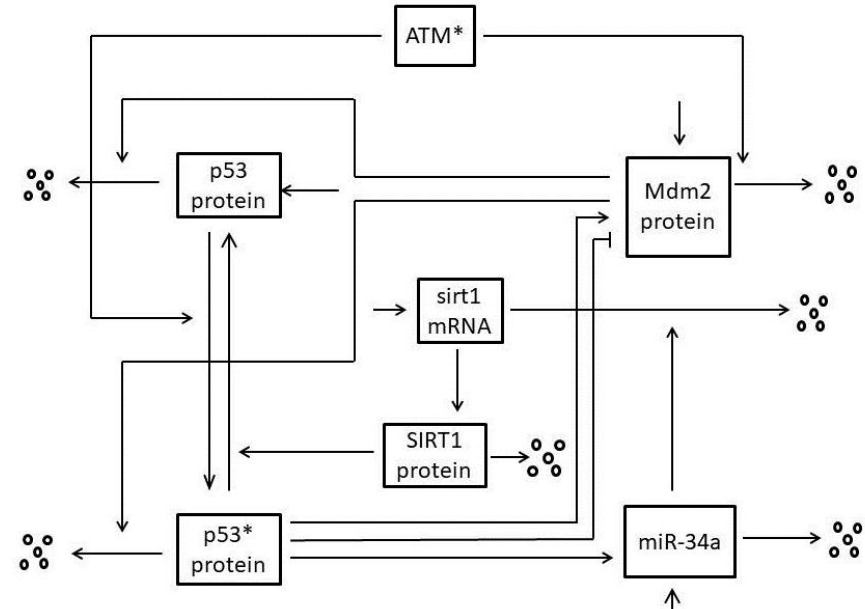
Figure 1. The p53 signal network. ATM* relays the DNA damage signal and induces activation of p53 from the inactive state to the active state (p53*). P53* is a transcriptional factor that can e ff